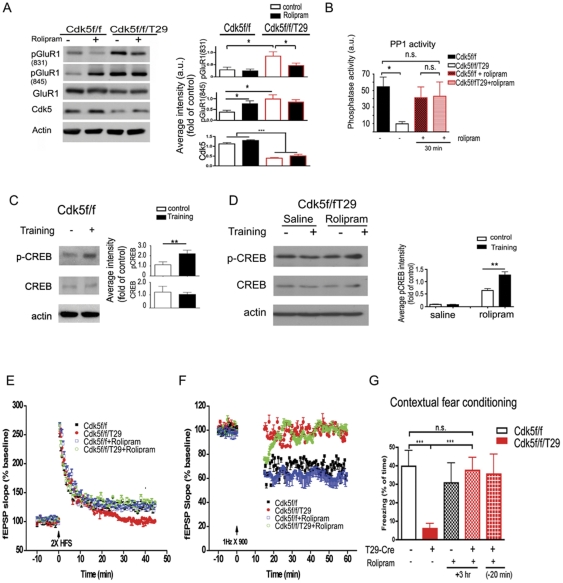
Inhibition of PDE4 by rolipram can restore LTP deficits and rescue memory impairments in Cdk5f/f/T29 mice.
A. Western blot from CA1 lysates after rolipram treatment. Samples were collected 20 min after rolipram or saline (control) injection. B. PP1 activity in area CA1 tissue was measured after rolipram treatment (0.1 mg/kg, i.p.). C. Western blots (left) for CA1 tissues from Cdk5f/f mice, with quantification (right). Mice were trained in a contextual fear conditioning paradigm followed by tissue harvest 20 min after training. n = 5 for each group. D. Western blots (left) from micro-dissected CA1 tissues from Cdk5f/f/T29 mice with quantification (right). Rolipram (0.1 mg/kg, i.p.) was injected 20 min before contextual fear conditioning training. Samples were collected 20 min after training (n = 3 for each group). E. Rolipram restored LTP deficits in the Cdk5f/f/T29 slices. Mice were injected with rolipram or vehicle (Veh) 20 min before sacrifice and slice preparation. Rolipram was also present in the bath solution at 0.7 µM. Slices were stimulated with two trains of HFS (100 Hz, 1 s; n = 6 for each group; *p<0.05, between vehicle- and rolipram-treated groups in Cdk5f/f/T29 mice). F. Rolipram did not rescue the LTD impairment in Cdk5f/f/T29 slices (n = 5 for each group). G. In a contextual fear conditioning task, the percent of time spent freezing in Cdk5f/f/T29 mice (n = 16) is significantly lower than that of control Cdk5f/f mice (n = 8). The percent freezing time for the Cdk5f/f/T29 mice injected with rolipram (0.1 mg/kg, i.p.) 20 min before training (n = 8) or 3 hr after training (n = 7) is similar to that of the control Cdk5 f/f mice.